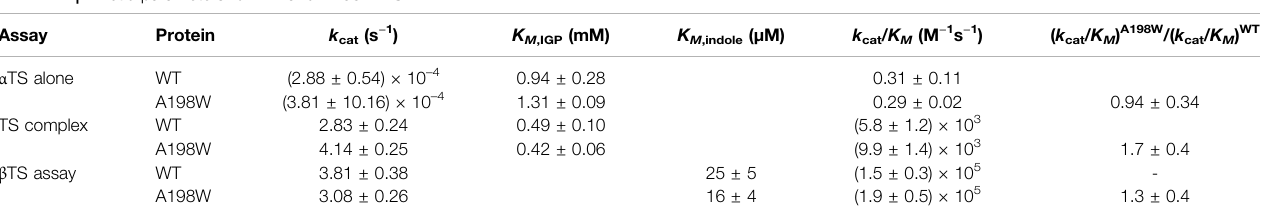
TABLE 1 | Kinetic parameters for WT and A198W